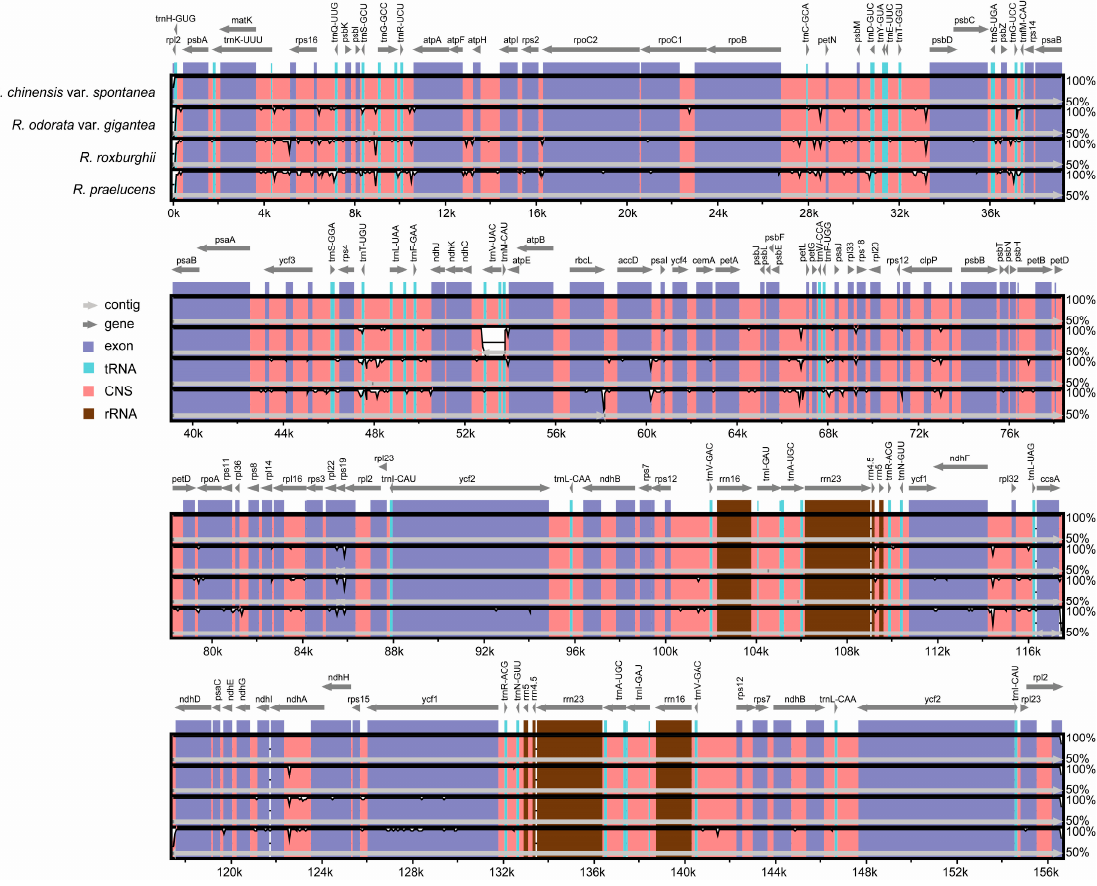
Figure 2. Complete chloroplast genome comparison of four rose species using the chloroplast genome of R. chinensis var. spontanea as a reference. The grey arrows and thick black lines above the alignment indicate the gene orientation. The y -axis represents the identity from 50% to 100%.